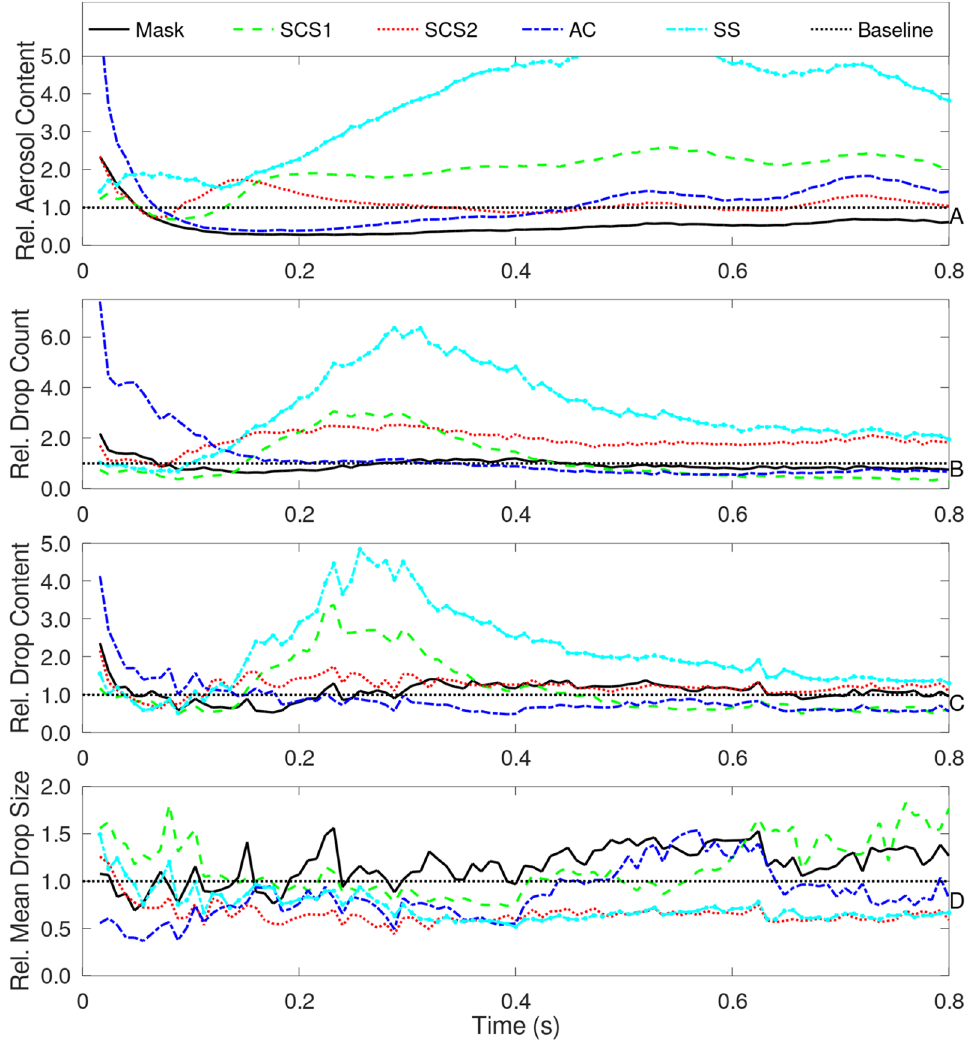
Figure 8. Image processed estimation of overall measures of aerosols and droplets with various modifiers including a baseline, mask, SCS1, SCS2, SS, and AC. The overall aerosol content (upper), droplet count or number of droplets (2nd row), droplet content or area exposed to droplets (3rd row), and mean droplet size (4th row) are all plotted versus time. Results are normalized by the